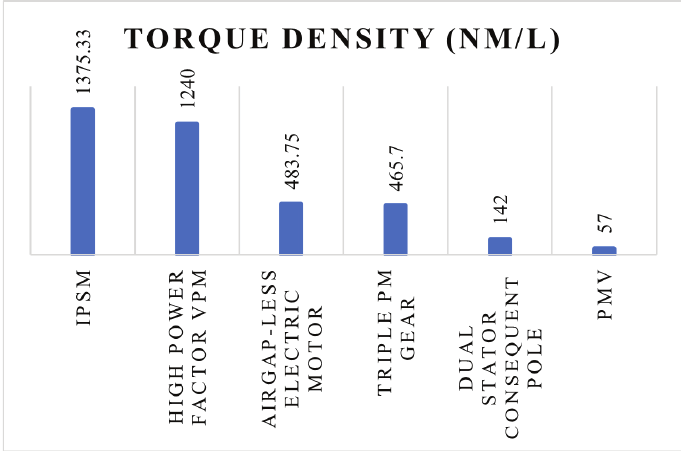
Figure 12. Torque density comparison chart for electric motors with permanent magnets. Except for the airgap-less electric motor, all other motors in this figure consist of permanent magnets, which will result in high torque and, at the same time, will add to the cost of the overall motor. Clearly, in this figure, the airgap-less electric motor does not win in terms of torque density, but as mentioned, there is no permanent magnet in the airgap-less electric motor. In turn, Figure 13 compares six high-torque electric motors without permanent mag- nets with the airgap-less electric